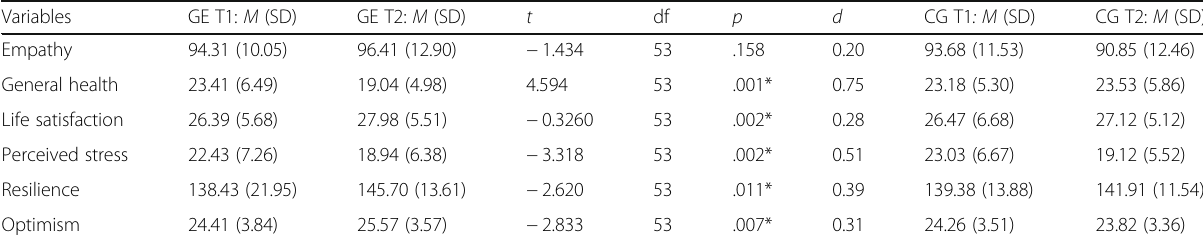
Table 2 Test statistics results for each outcome measure in the EG ( n = 54) and CG ( n = 34)